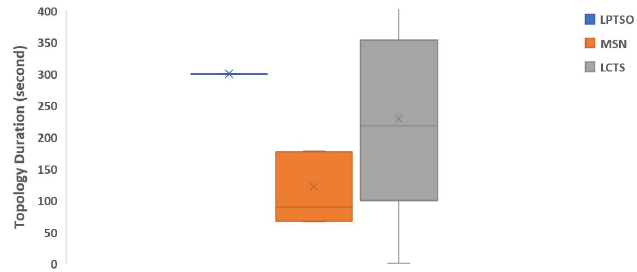
Figure 10. Topology duration with three different methods.